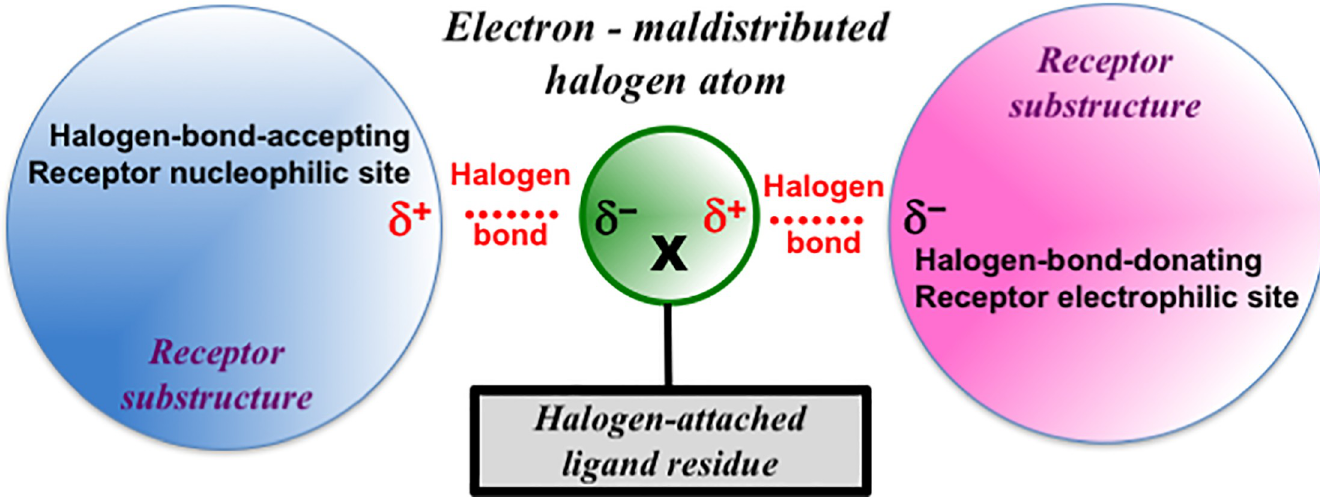
Fig 7. Schematic diagram of halogen bonding. Halogen bonds exist between the halogen atom X (F, Cl, Br, or I) and the electron-rich δ – and/or electron-poor δ + sites in the receptor protein. The electrons of atom X in the ligand molecule are maldistributed to the electron-rich δ – and electron-poor δ + portions.